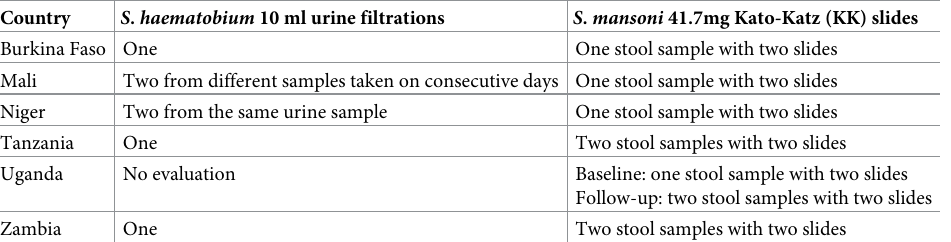
Table 1. Summary of Schistosoma infection data collection procedures by country, Schistosomiasis Control Initia- tive (SCI) supported monitoring and evaluation data, 2003–2008.